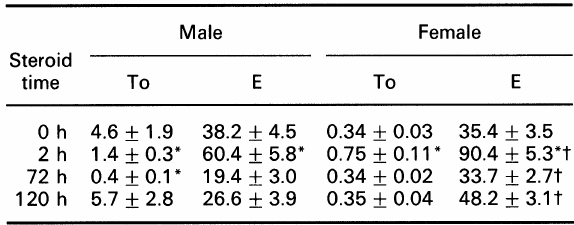
___ FIG. 3. Anterior pituitary gland (AP) ACTH content before and several times after endotoxin treatment in adult mice of both sexes. Bars represent S.E.M. (n 6-8 mice per group). the mean respective sample time zero.